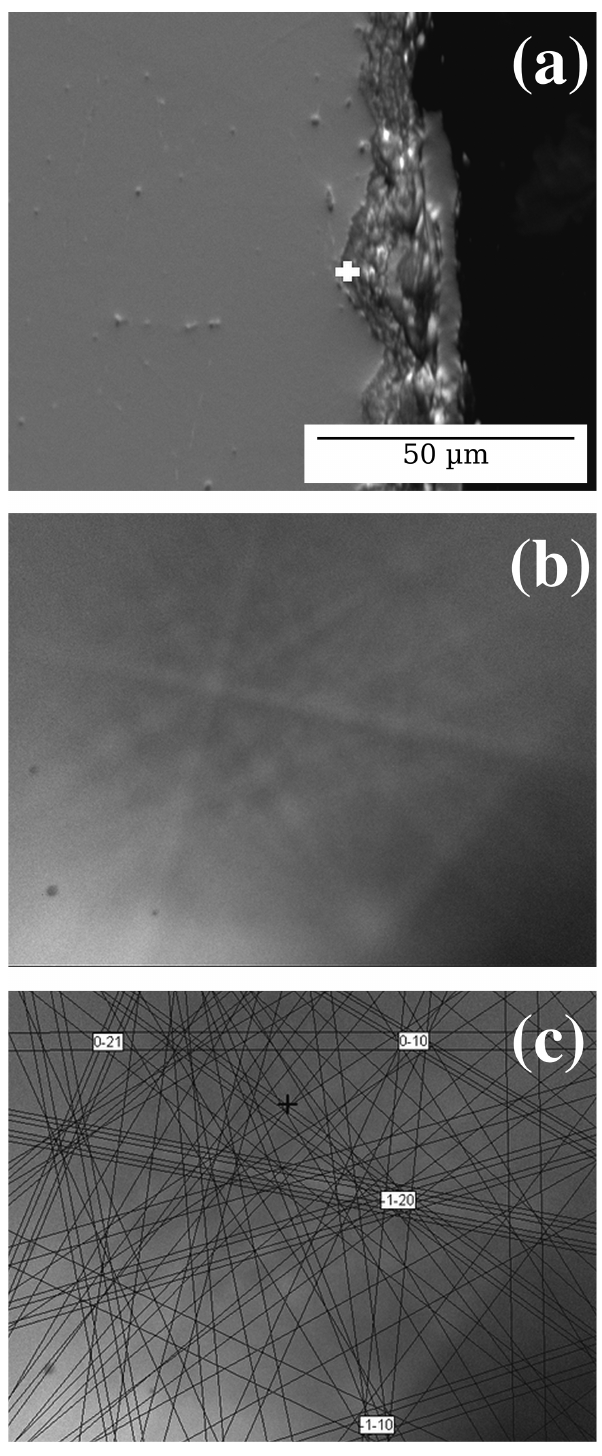
Figure 5: The results of EBSD analysis of the internal part of the oxide scale growing on the surface of the X2CrNiMo17-12-2 steel sample: (a) cross-section of oxidized steel sample with marked micro-region, in which the EBSD analysis has been performed (b) an electron backscatter diffraction pattern (c) results of simulation of indexed planes for crystalline Cr 2 O 3